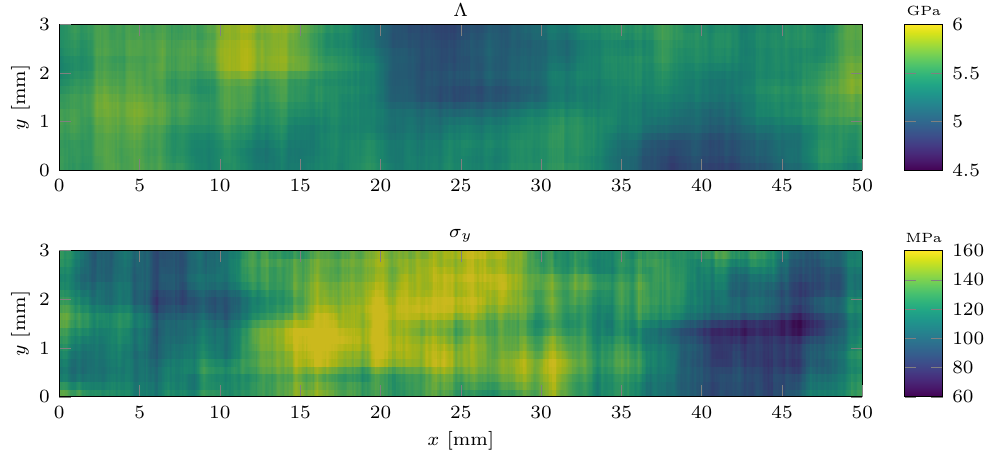
Figure 3. Representation of the spatially distributed material parameters of elastic–ideal plastic material behavior by cross-correlated homogeneous second-order Gaussian random fields.